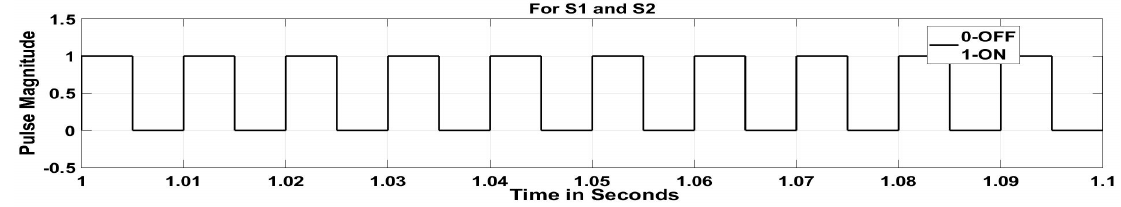
Figure 10. Simulink simulation of control pulses for DC–DC buck mode.